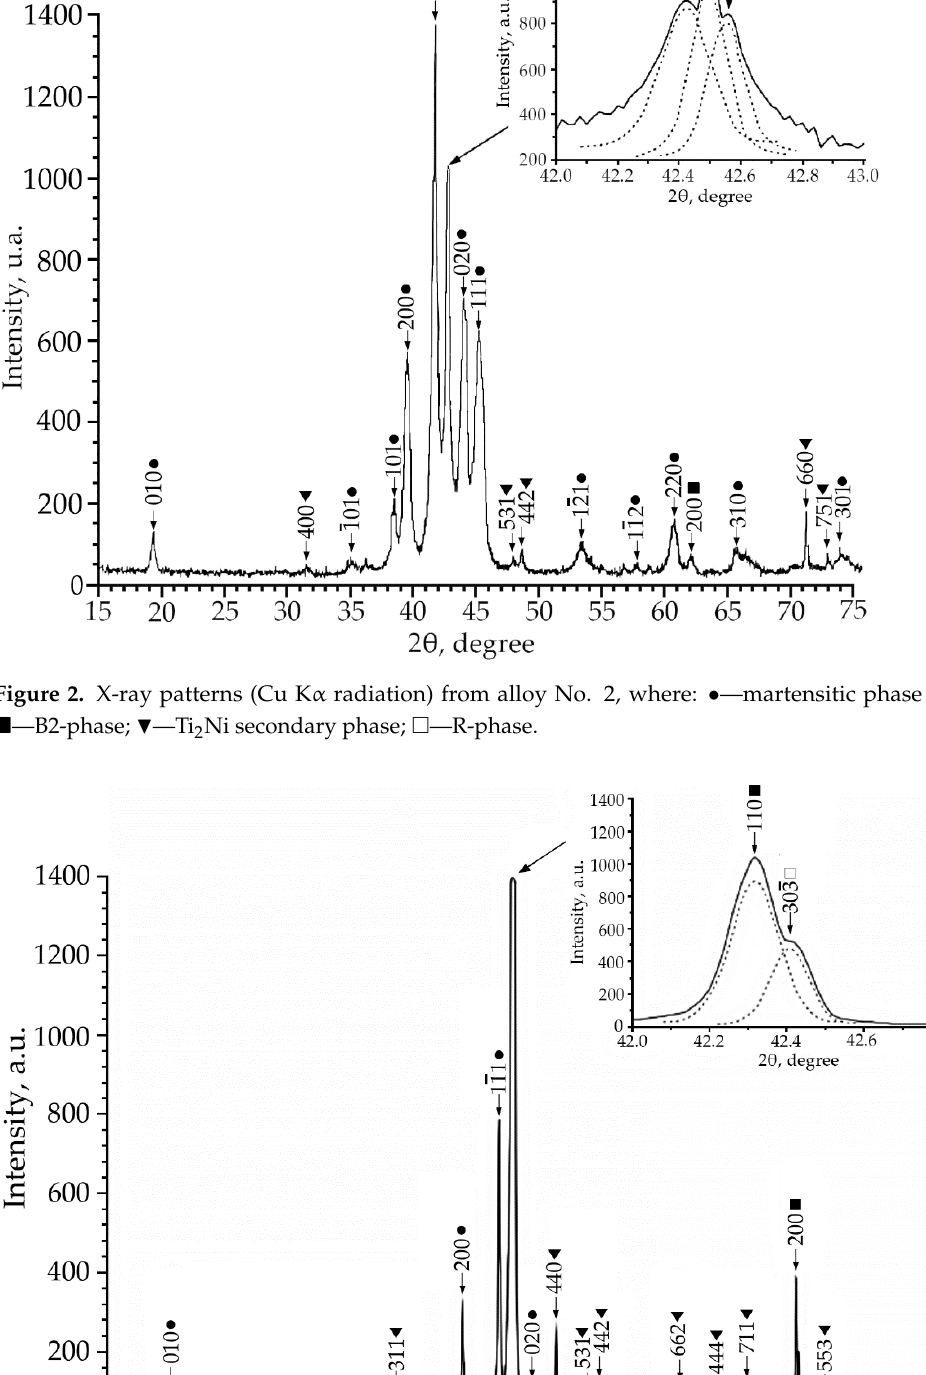
Figure 3. X-ray patterns ( Co Kα radiation) from alloy No. 3, where: •—martensitic phase В19′ ; ■ — В2 -phase; ▼ — Ti 2 Ni secondary phase; — R-phase.